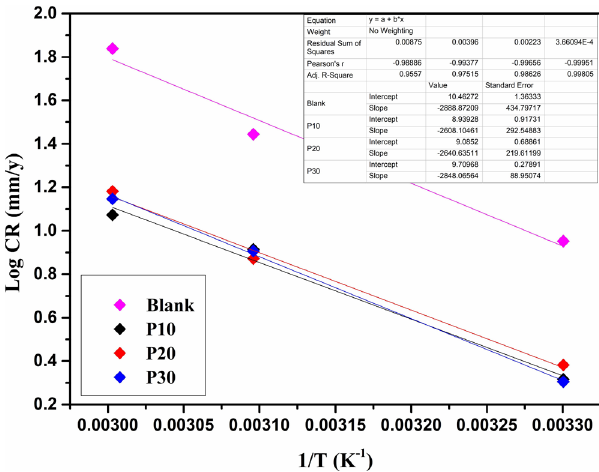
Figure 7. Arrhenius plots for API P110 carbon steel in 1 M HCl in the absence and presence of the inhibitors